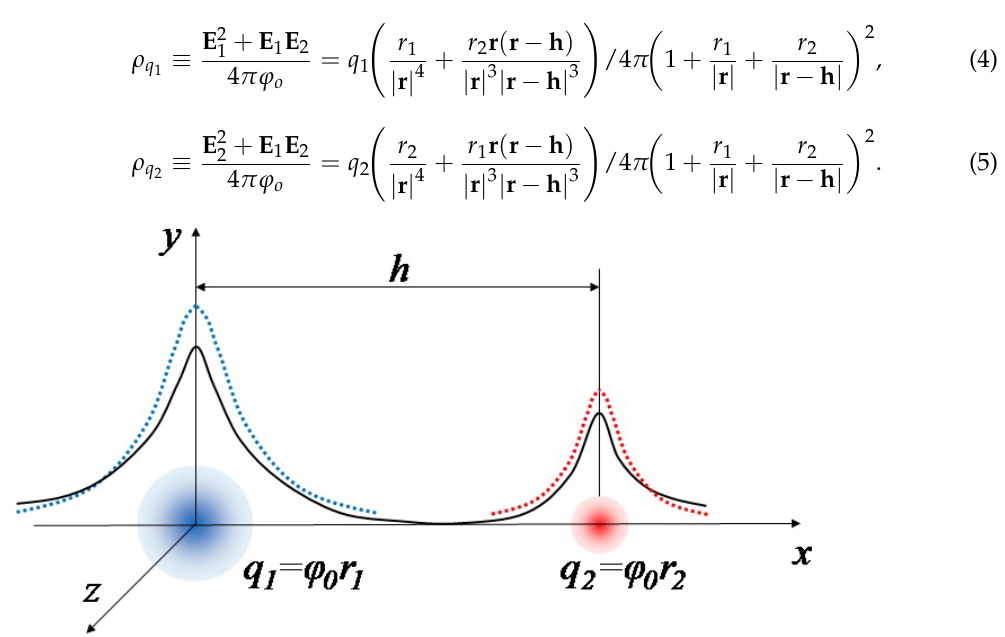
Figure 1. The dotted lines are equilibrium radial densities for h → ∞ ; the solid curve is for the nonequilibrium density of non-local charge–energy with asymmetric